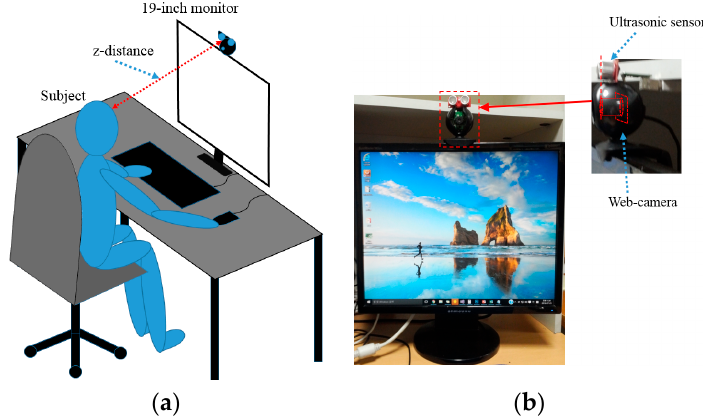
Figure 1. Experimental environment of our method: ( a ) conceptual diagram; and ( b ) example of setup of web-camera and ultrasonic sensor on the 19-inch monitor.